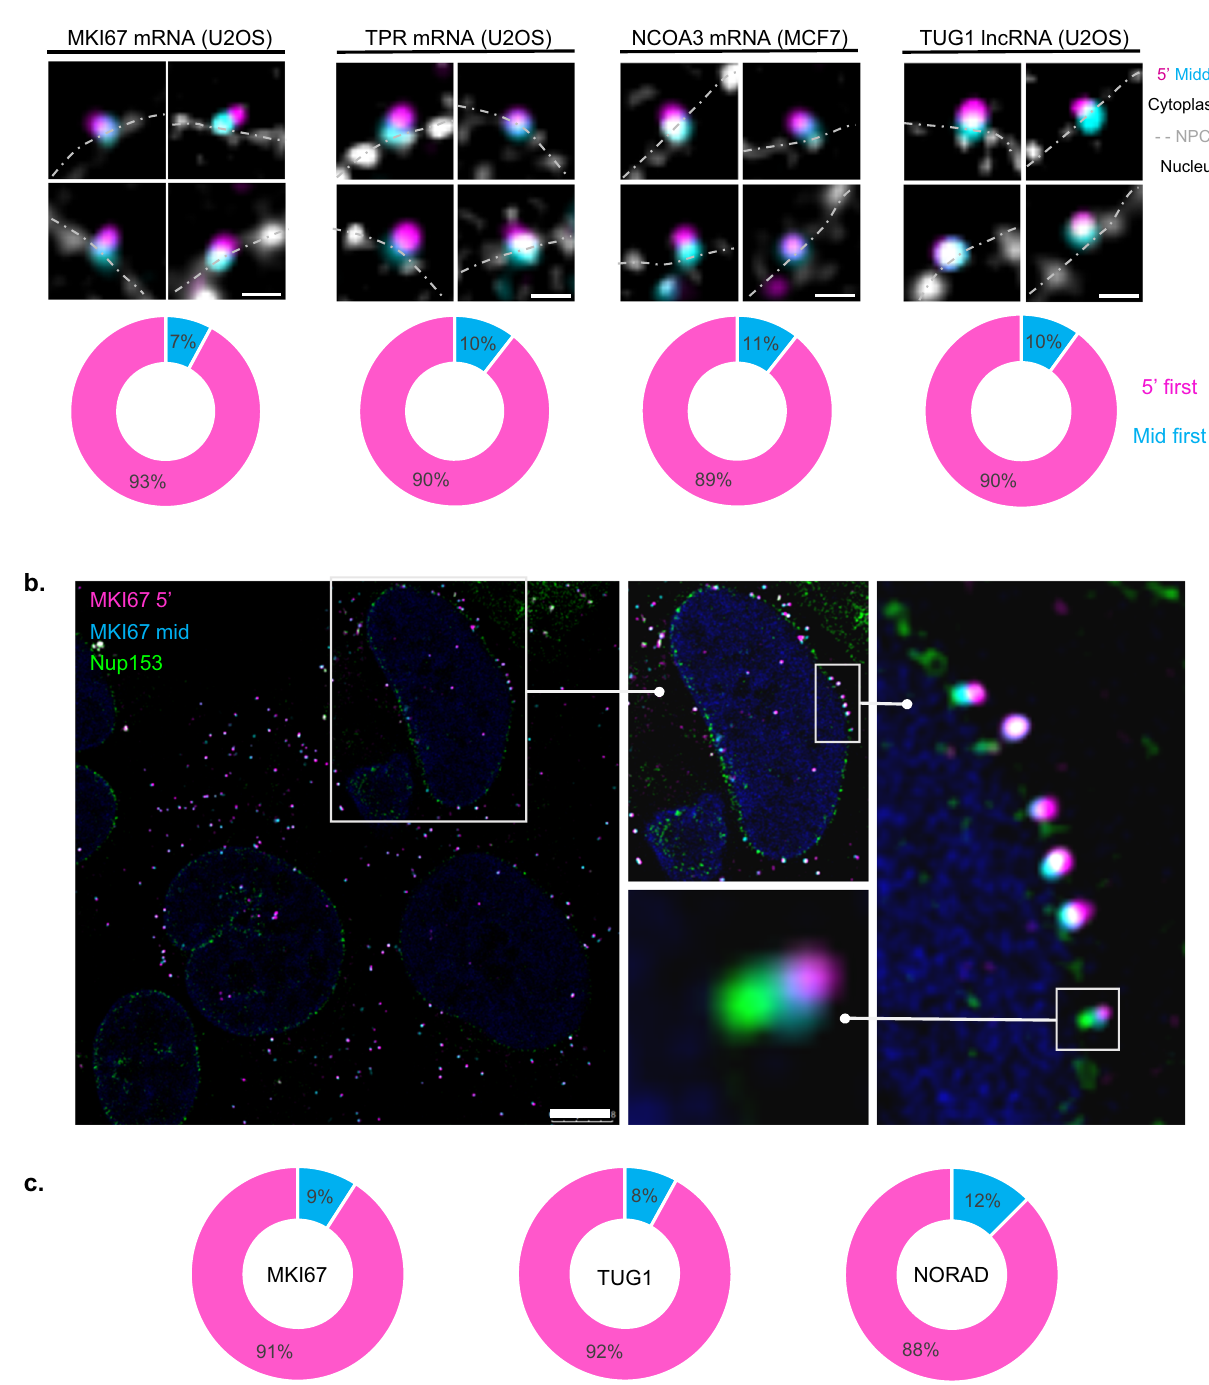
Fig.5|ExportdirectionalityofendogenousmRNAsandlncRNAs.a MKI67,TPR, NCOA3 mRNAsand TUG1 lncRNA double-tagged transcripts in their 5'and middle regions (5 ’— magenta, middle — cyan) together with POM121-Cer labeling (gray). Charts describing the percentage of transcripts exiting the pore in a 5 ’ -manner (magenta) or middle- fi rst (cyan). MKI67 n =105, TPR n =50, NCOA3 n =53, TUG1 n =30 transcripts. Dotted line — nuclear borders; cytoplasm above and nucleus belowthe line. Scalebar, 0.5 µ m. b Double-taggedMKI67 transcripts (5 ’— magenta,